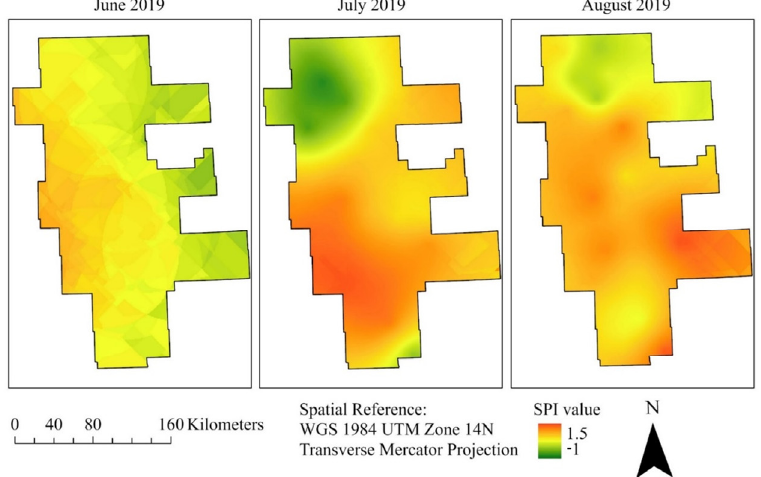
Figure 10. Standardized Precipitation Index (SPI) maps created using rainfall data from 25 weather stations by ordinary kriging interpolation in the RRVN for the June, July, and August months of 2019.